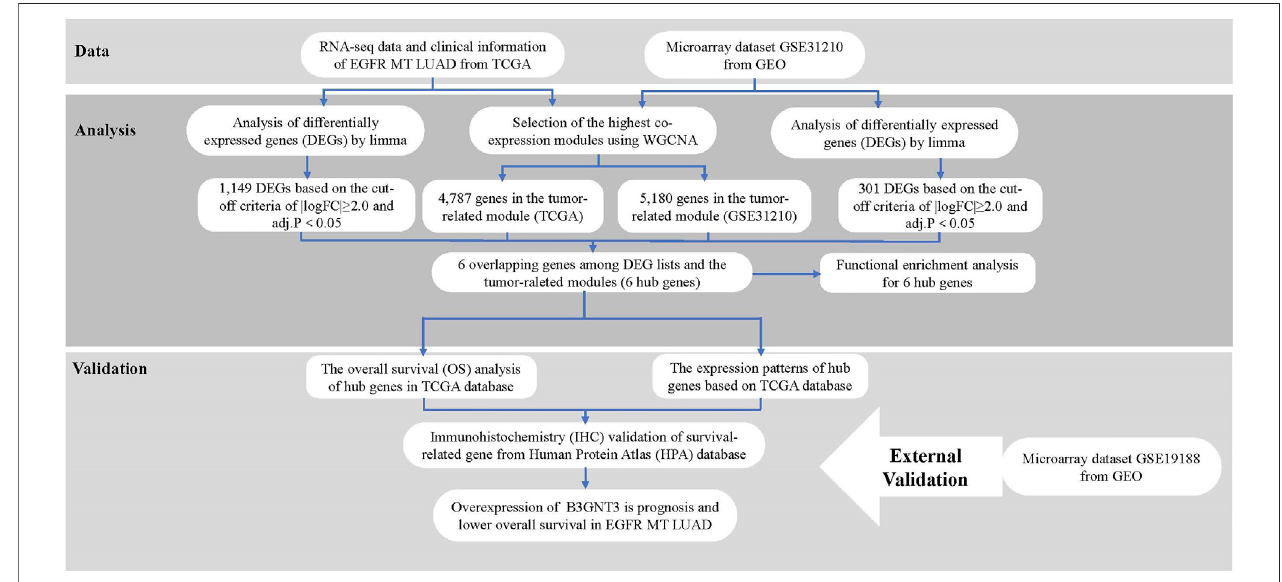
FIGURE 1 | Study design and work fl